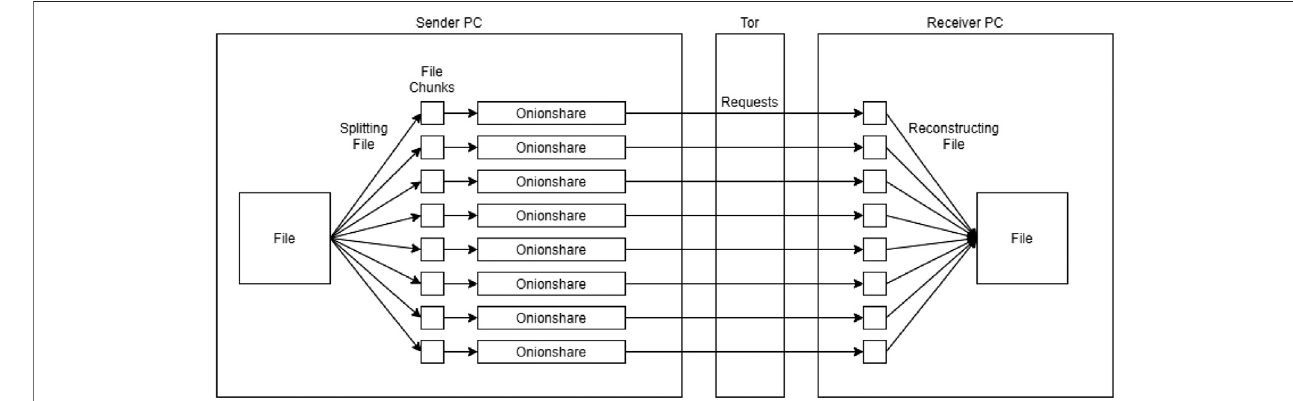
FIGURE 6 | File transfer process.